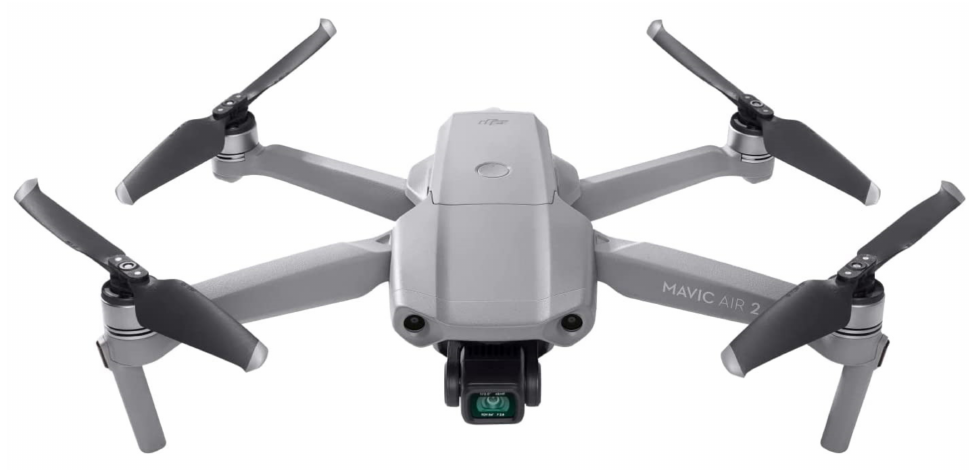
Figure 6. The drone used in this dam inspection task. Table 1. The related parameters of drones and